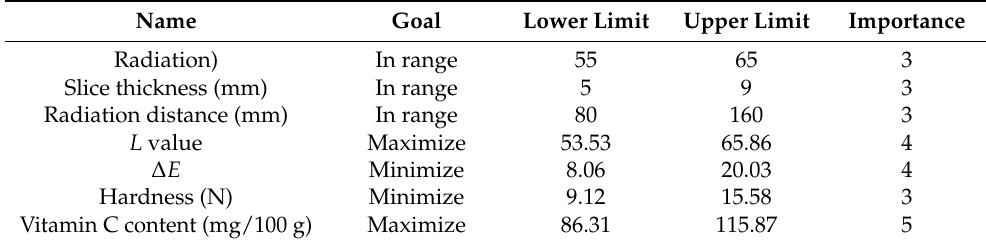
Table 6. Numerical optimization for optimum conditions.